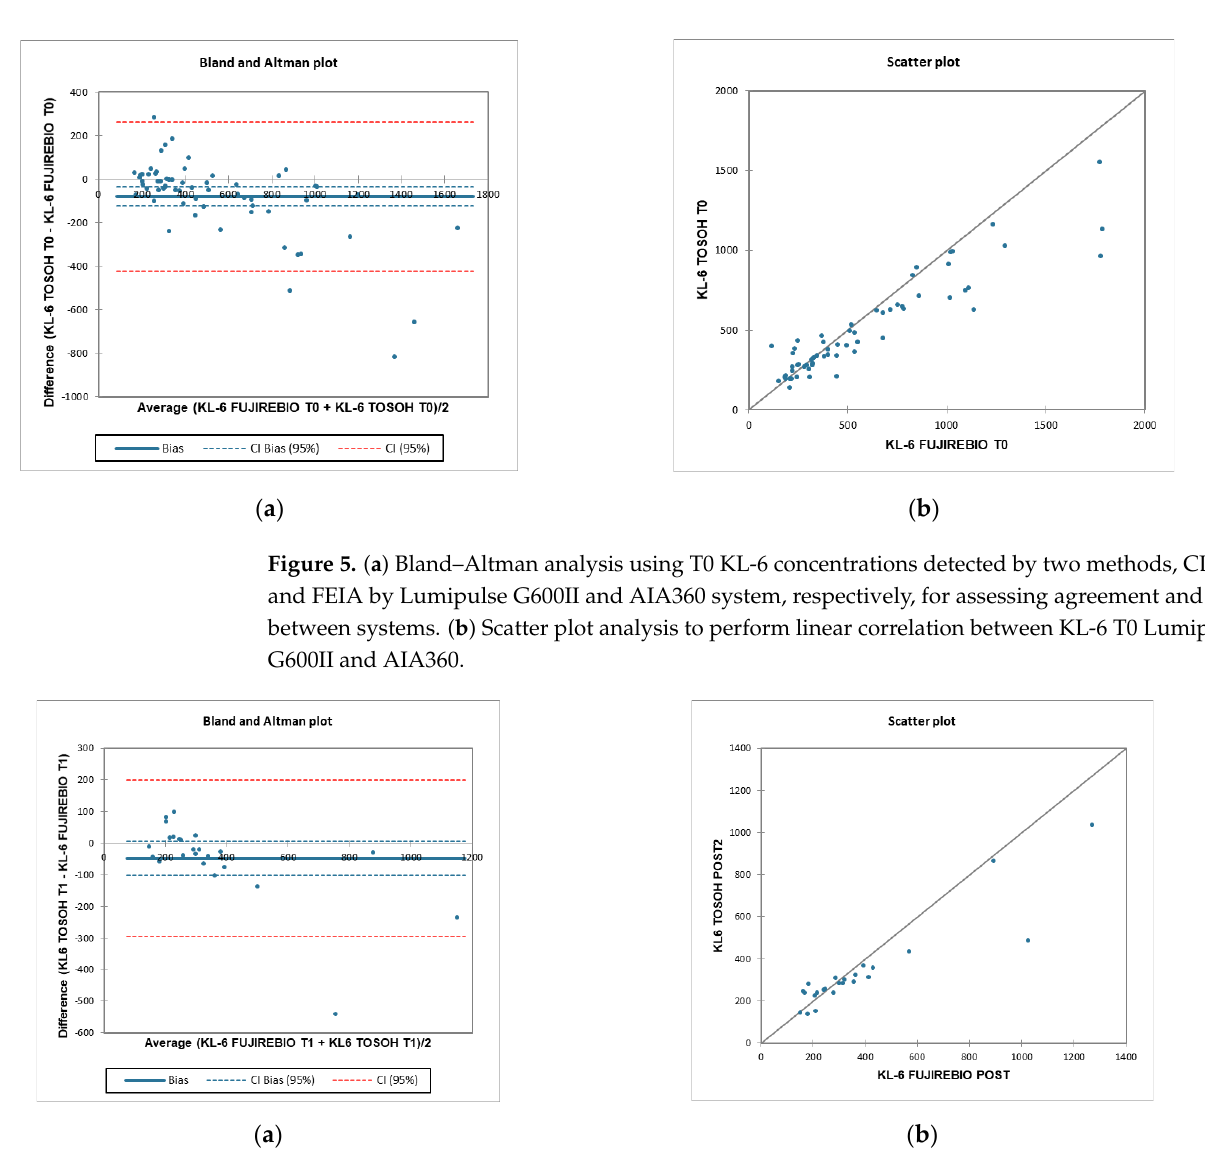
Figure 6. ( a ) Bland–Altman analysis using T1 KL-6 concentrations detected by two methods, CLEIA and FEIA by Lumipulse G600II and AIA360 system, respectively, for assessing agreement and Bias between systems. ( b ) Scatter plot analysis to perform linear correlation between KL-6 T1 Lumipulse G600II and AIA360.